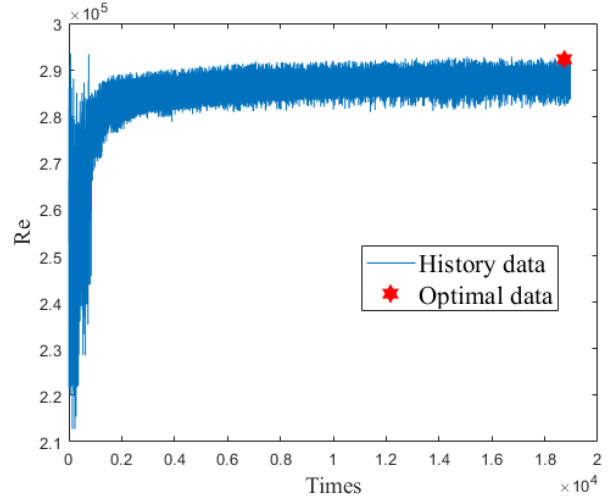
Figure 8. Evaluation factor Re optimisation history.